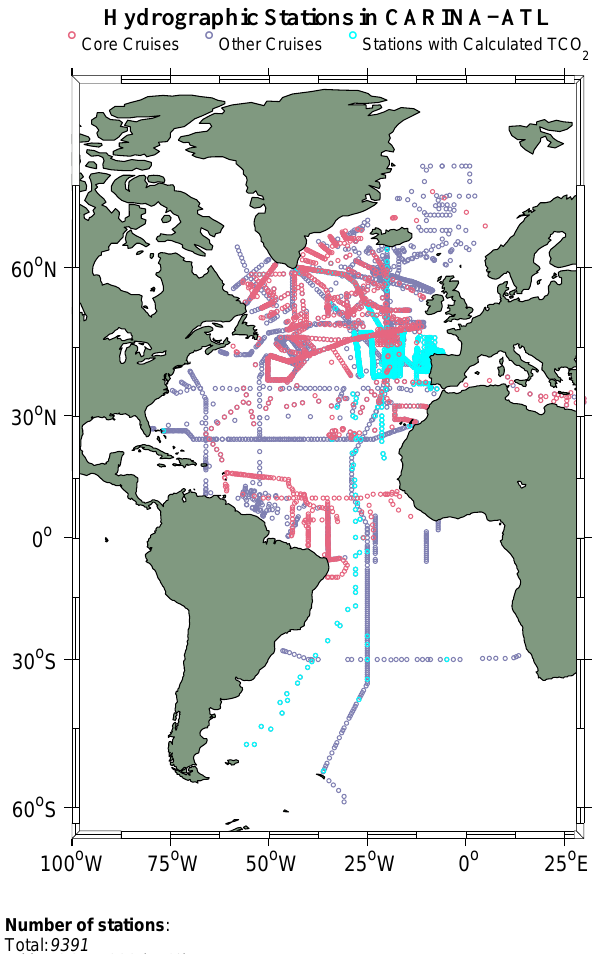
Figure 1. Plot of all the hydrographic stations in CARINA-Atlantic data set (CARINA-ATL). Only about half the stations (stations “with TCO 2 ”) reported TCO 2 values (measured or